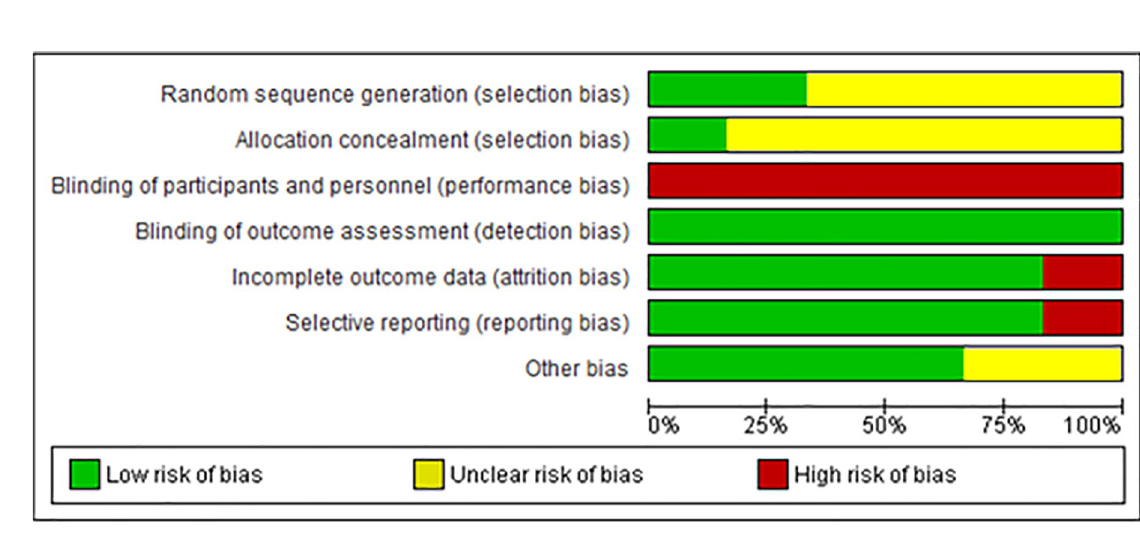
Fig 2. Risk of bias